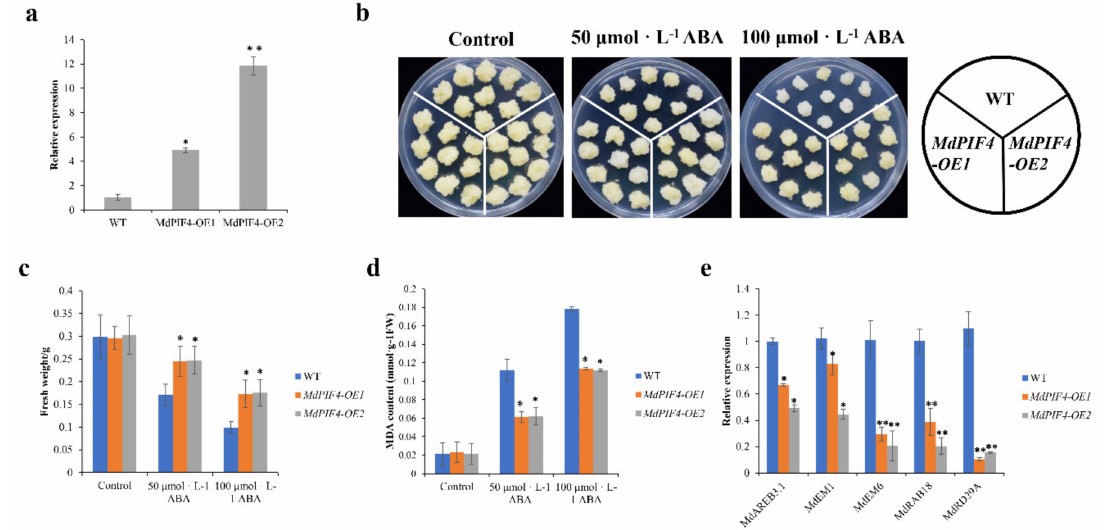
Figure 7. Reduced ABA sensitivity of MdPIF4 transgenic apple callus. ( a ) Expression analysis of MdPIF4 in WT and transgenic calluses. 18S ribosomal RNA was used as an internal control. ( b ) The phenotypes of 14-day-old transgenic and WT apple calluses cultured on Murashige and Skoog (MS) medium containing di ff erent concentrations of ABA for 20 d. ( c ) Statistical analysis of fresh weights for the transgenic and WT apple calluses after treatment. ( d ) Statistical analysis of the MDA concentrations in transgenic and WT apple calluses after treatment. ( e ) The gene expression of ABA response genes in WT and transgenic calluses after ABA treatment. Data are mean ± SD of three independent replicates. Asterisks denote significant di ff erences from control (*, p < 0.05; **, p <